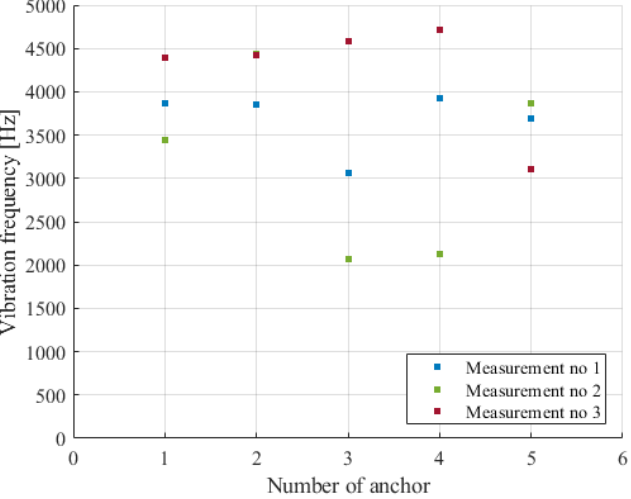
Figure 13. Measurement of anchor vibration frequency in a Klein II transverse without